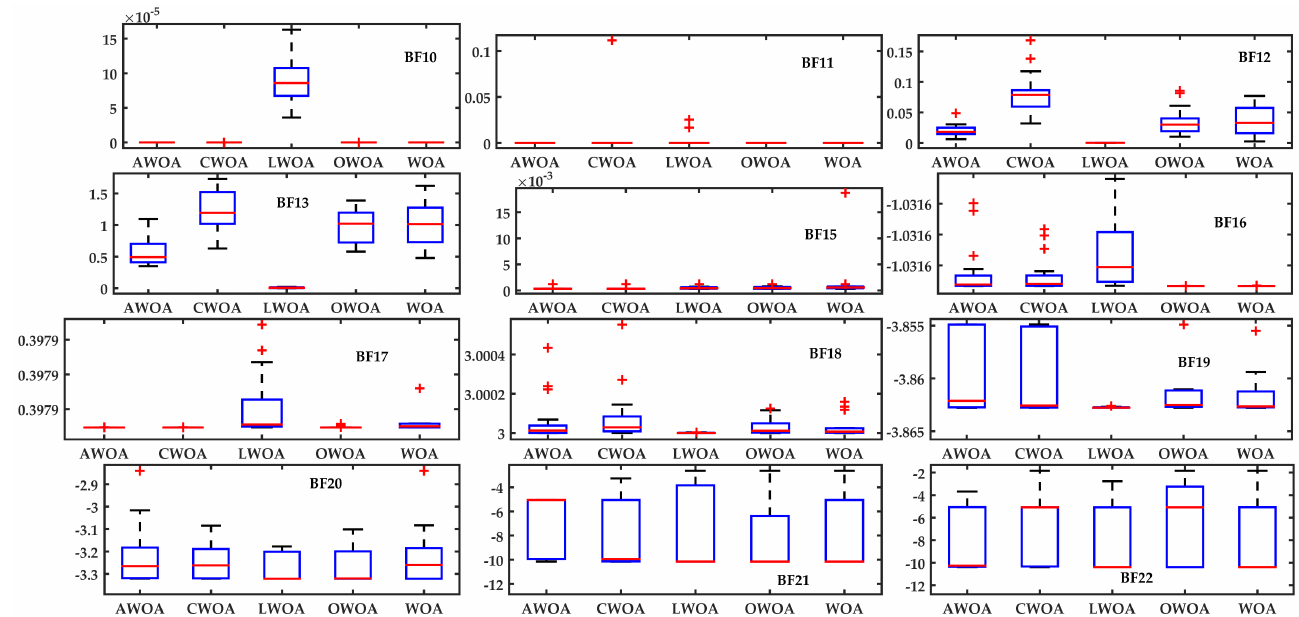
Figure 8. Boxplot analysis of the remaining functions of Benchmark Suite